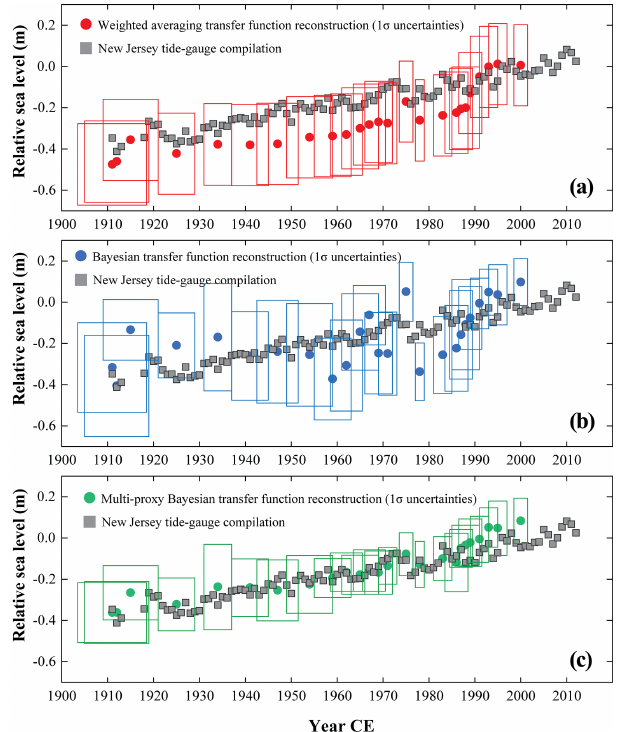
Figure 7. Comparison of the weighted average transfer func- tion (a) , the Bayesian transfer function (b) and the multi-proxy Bayesian transfer function (c) relative sea-level reconstruction with tide gauge data observed in the New Jersey region. The boxes rep- resent ± 1 σ uncertainty region for the